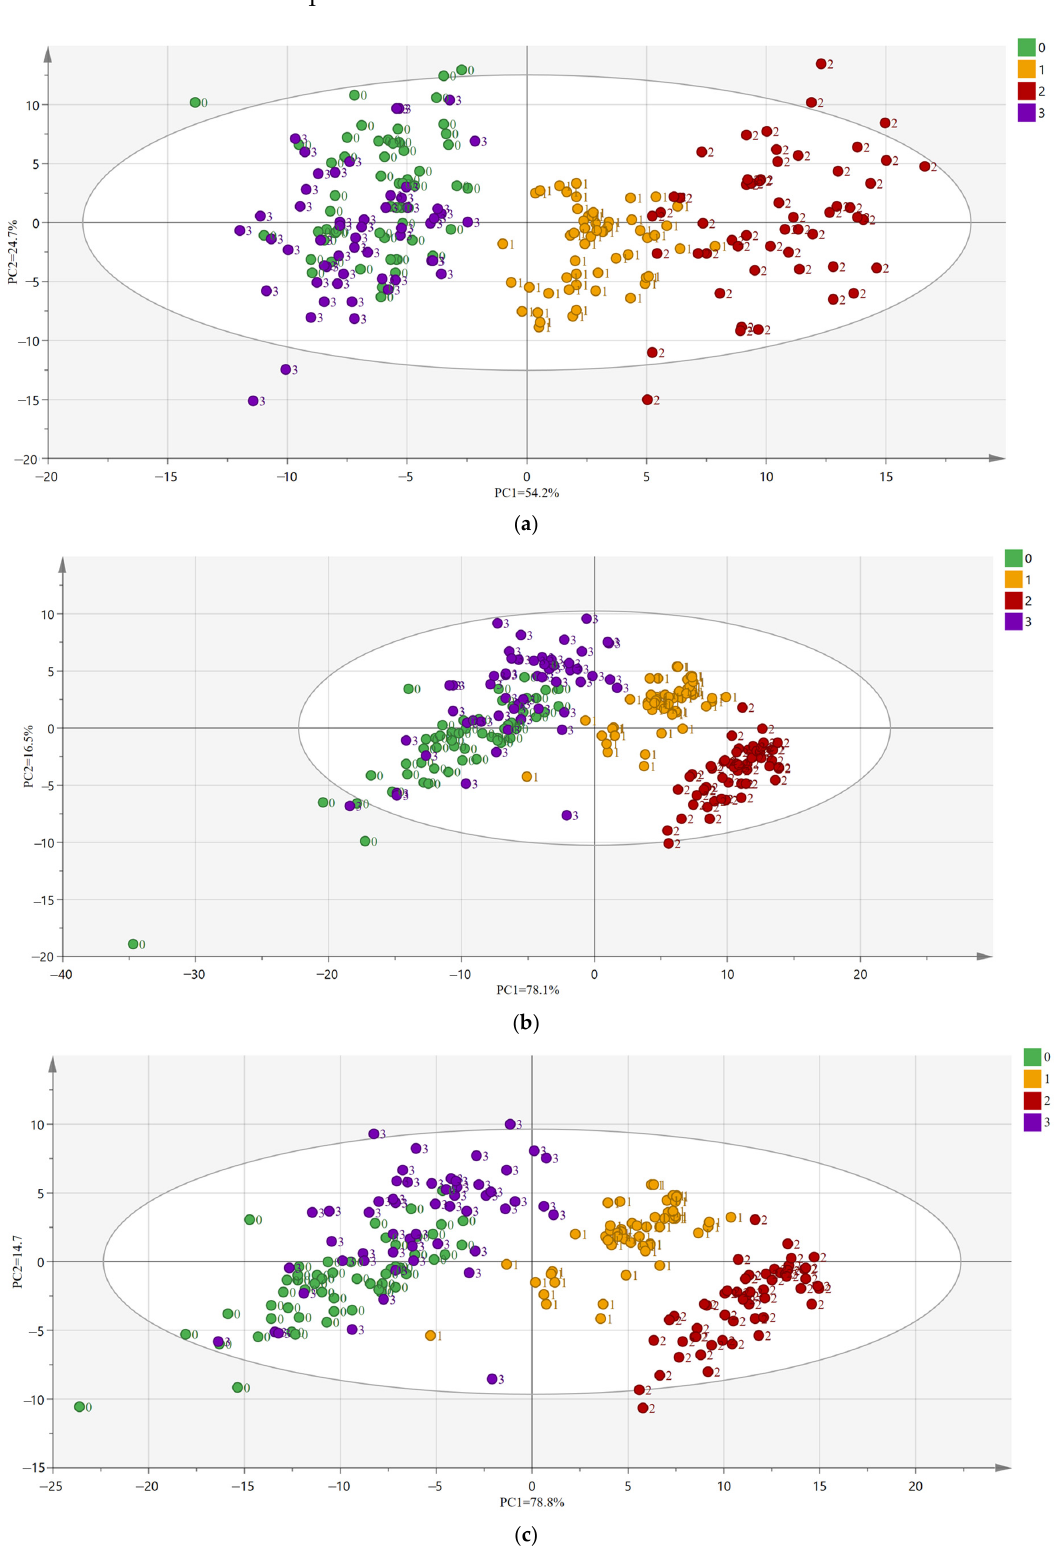
Figure 2. PCA score plots of four oolong teas. ( a ) The PCA of the raw spectra; ( b ) the PCA of the spectra after MSC; and ( c ) the PCA of the spectra after SNV. (0 represents Tieguanyin, 1 represents Maoxie, 2 represents Huangjingui, 3 represents